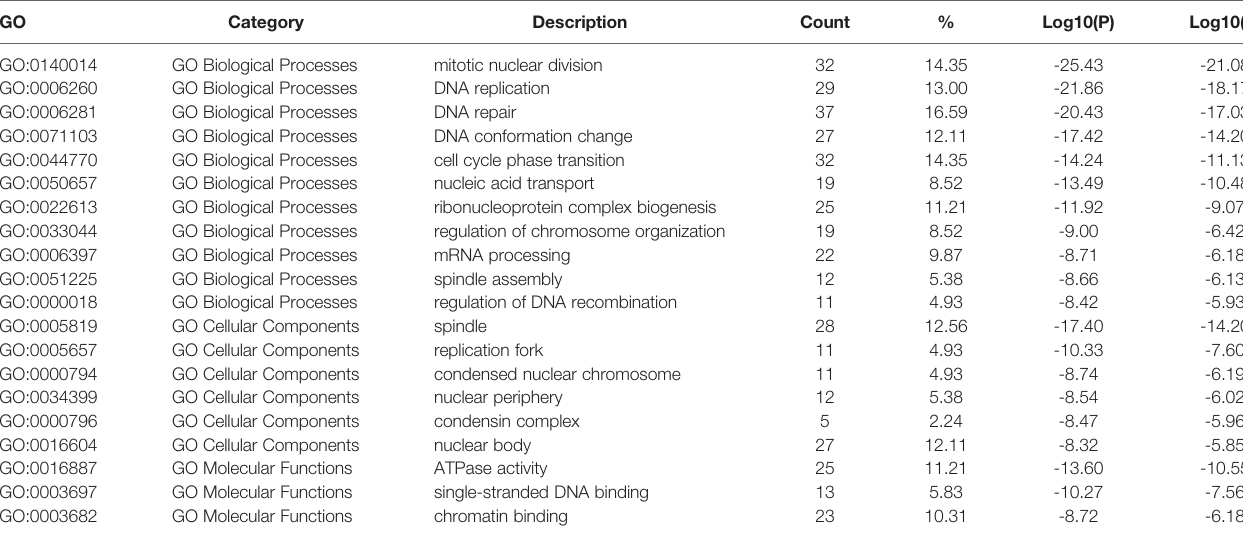
TABLE 3 | GO function enrichment analysis of E2Fs and their similar genes in STAD (Metascape). GO Category Description